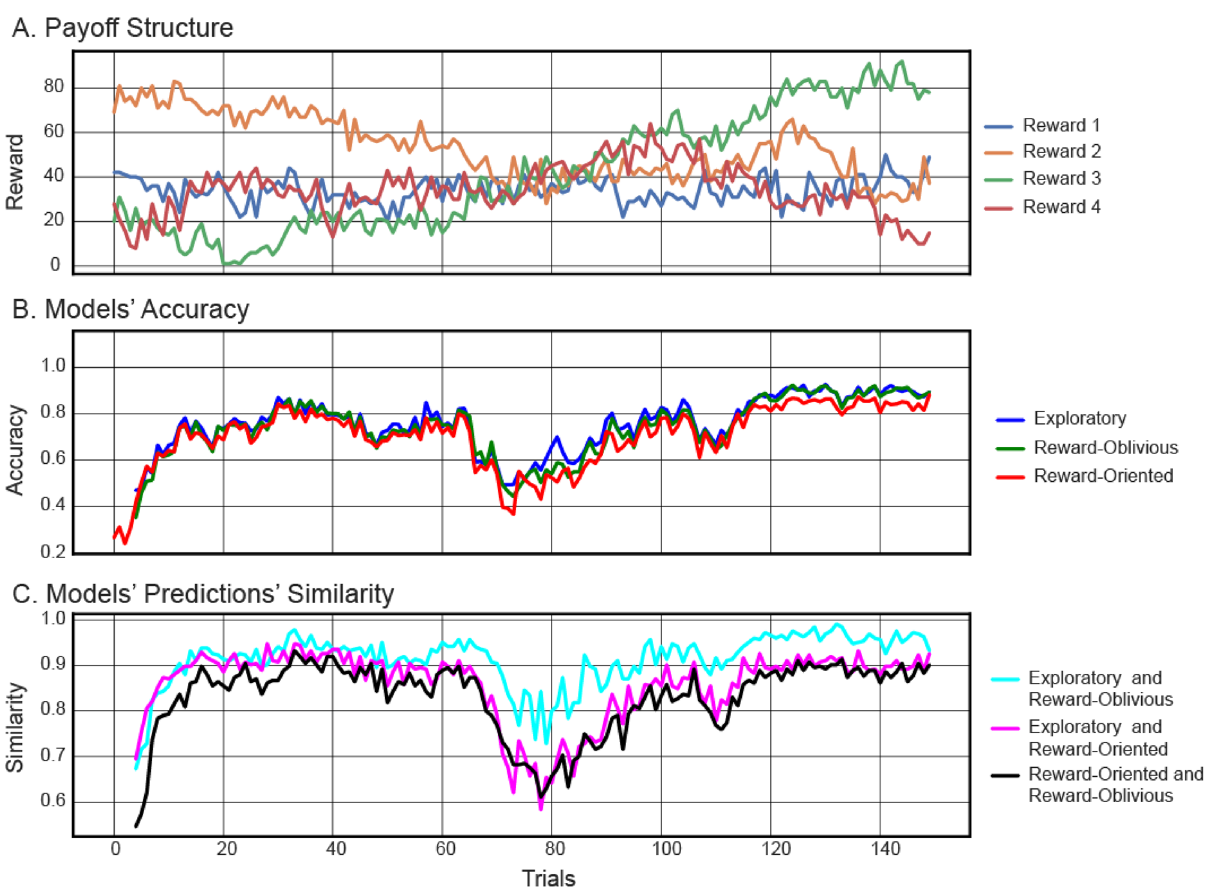
Figure 3. Analysis of models’ prediction over time–payoff structure 1. ( A ) Payoff structure indicates times when all options were similar and times when one option was distinctively better than others (payoff structure 1, for other payoff structure see Supplementary Materials). ( B ) Models’ prediction accuracy on trial-by-trial basis. Gaps between the lines indicate the differences in accuracies between the models. ( C ) Measure of similarity in predictions between pairs of models over